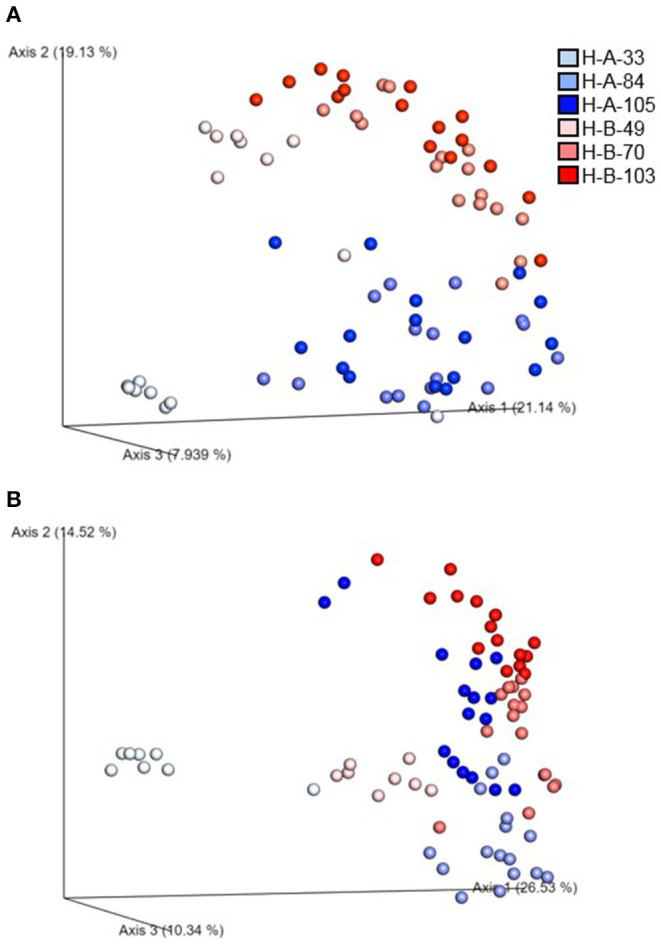
Emperor plot showing beta diversity distances among the different samples in H farm in Northwest Arkansas as measured by (A) unweighted UniFrac distance and (B) Bray-Curtis distance indices. (A,B) represent two different flocks of H farm, whereas the number represents the ages of turkeys when samples were collected.